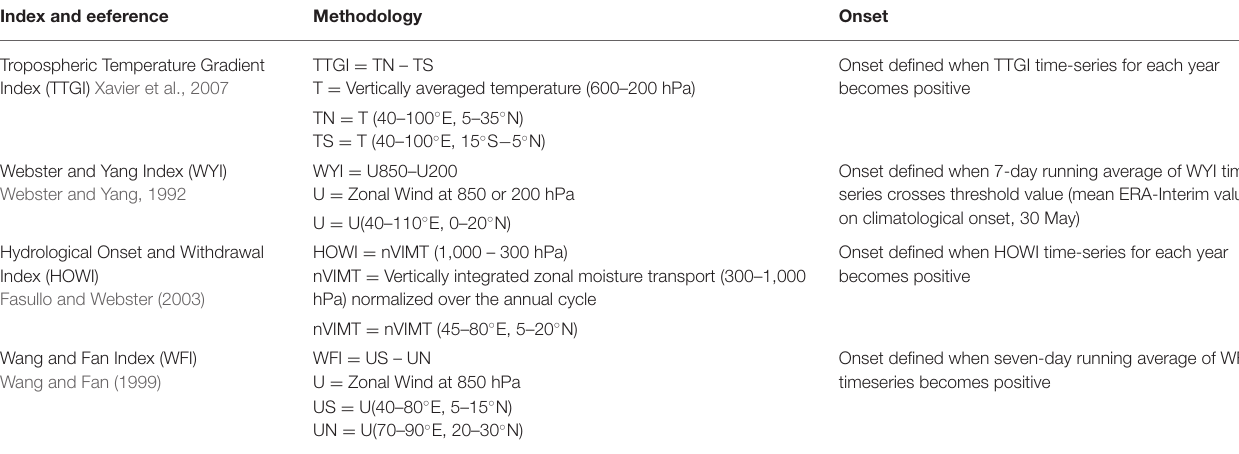
accurate estimate of the onset dates compared to the standard TABLE 2 | The monsoon onset dates computed using different methods for all experiments along with the IMD reported onset dates. nudging methods. Spectral nudging further showed important sensitivity to the choice of the wave numbers have in terms of the TTGI WYI HOWI WFI simulation of the pressure gradients and the corresponding onset dates. Spectral nudging simulations generally improved with higher number of waves and became comparable to CDA, when its number were retained. Overall, the dynamical downscaling simulations using the different nudging techniques successfully estimated the dates of MOK using the large-scale (TTGI and WYI) and small-scale (HOWI and WFI) indices, in agreement with the IMD. In contrast, WRF-CTL provided good estimate of MOK using the indices based on large-scale (TTGI and WYI), but not using those based on the small-scale features (HOWI and WFI), pointing to weaknesses at resolving ISM fine-scale features.